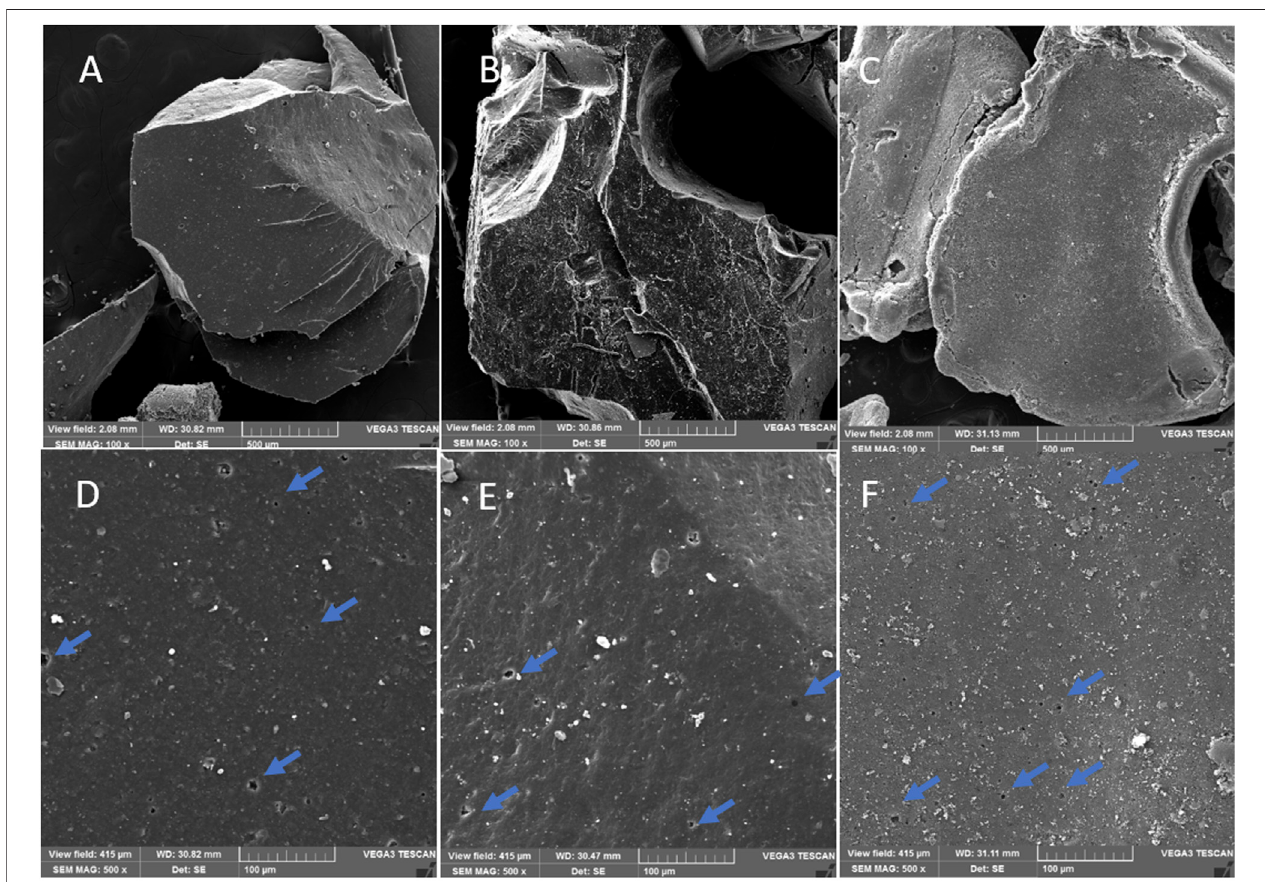
FIGURE3| Particlemorphologyandobservableporosityintheanalyzed samples,correspondingtocontrolat100x (A) and500x (D) ,biologicaltreatmentat100x (B) and 500x (E) , and chemical treatment at 100x (C) and 500x (F) . Blue arrows show pores on the surface.